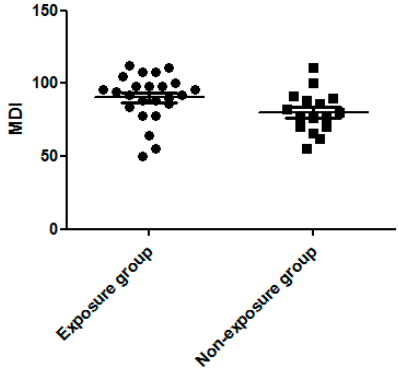
Figure 1. Significantly higher Mental Development Index (MDI) in the dexamethasone exposure group than the non-exposure group.